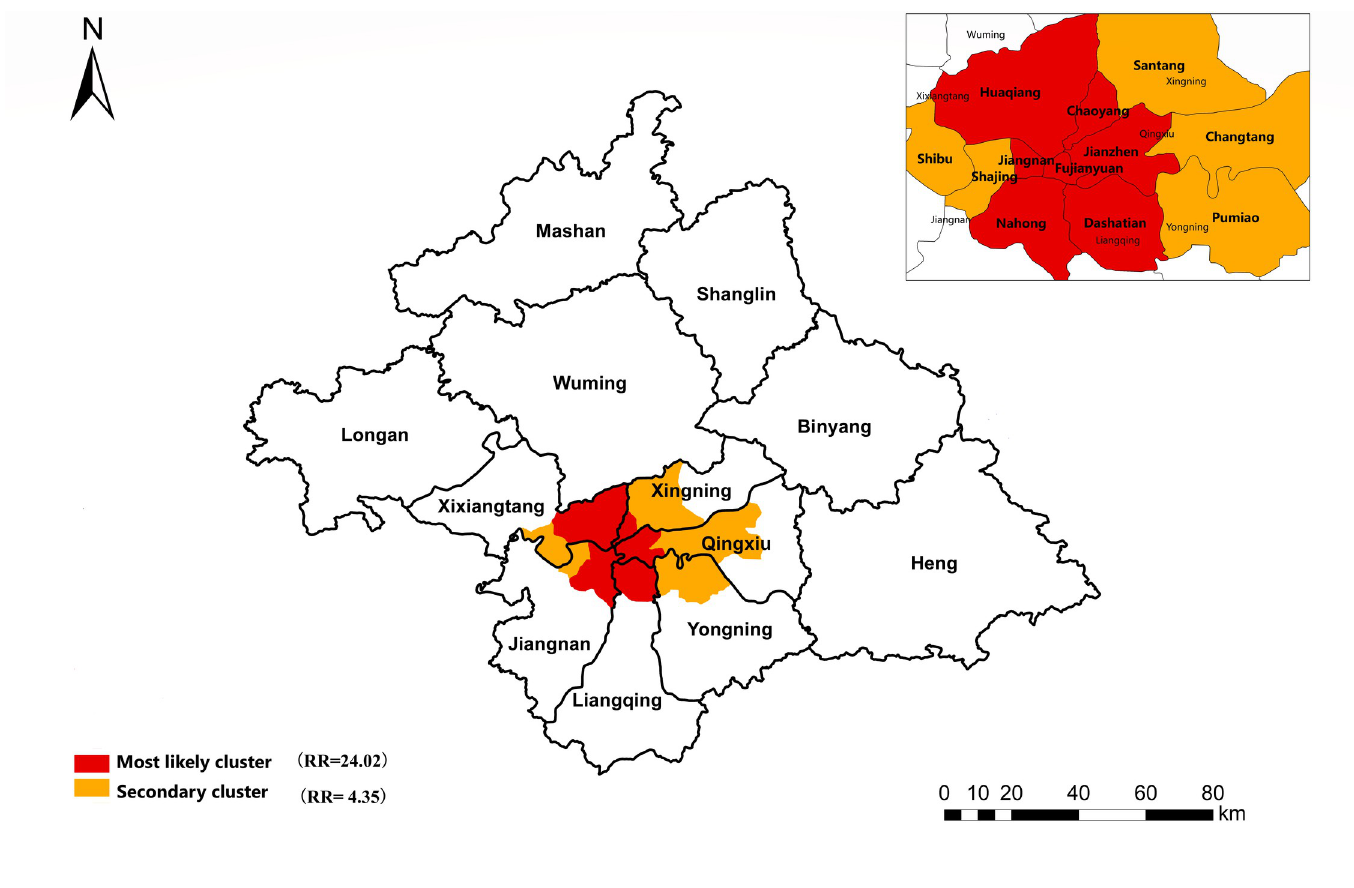
Fig 6. High-incidence clustering of reported incidence of pulmonary tuberculosis among students in Nanning.